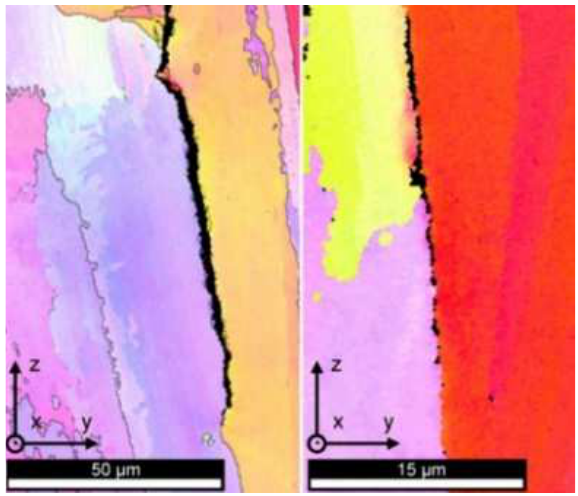
Figure 18. The hot cracks in CZ of the IN 738LC cladded layer (the laser power is 200 w, and the scanning speed is 600 mm/min) [102].